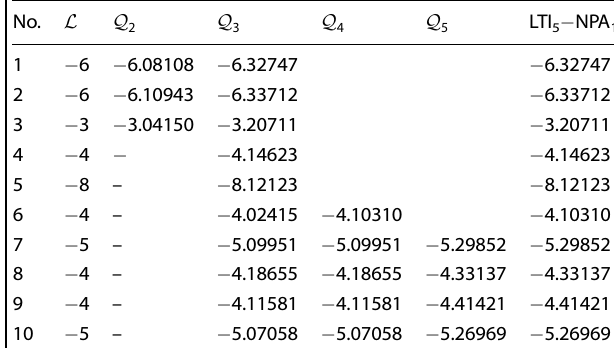
Table 3. The ground state energy density Q d of ten 322-type TI quantum systems that reach the LTI 5 − NPA 1 lower